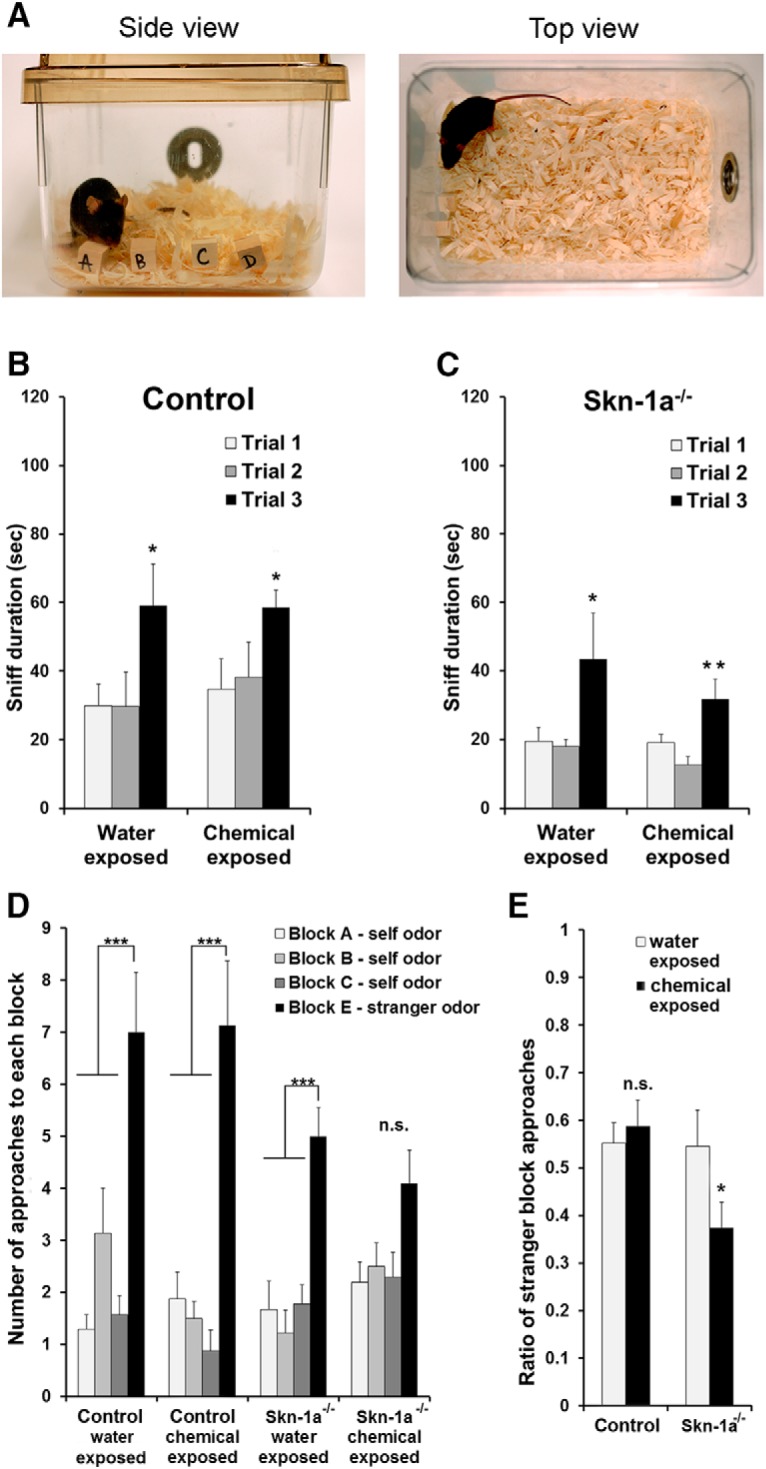
The number of approaches to a novel social odor is reduced in Skn-1a-/- mice after chemical exposure. A, Photographs of the experimental setting for the block test. Four scented blocks were placed into the cage. Left panel: side view, a mouse was sniffing block A. Right panel: top view. B, Sniff duration for each trial in water- and chemical-exposed groups of control mice. There were three trials total with each lasting 120 s. All blocks in trials 1 and 2 were scented with the mouse’s own odors. In trial 3, the block D was replaced with a block scented with a stranger odor (block E). Control mice of both water- and chemical-exposed groups sniffed significantly longer in trial 3 (*, p < 0.05, trial 3 vs. trial 2, t test, n = 7–8). C, Sniff duration for each trial in water- and chemical-exposed groups of Skn-1a-/- mice. Skn-1a-/- mice in both conditions displayed significantly longer sniff duration in trial 3 (*, p < 0.05, **, p < 0.01, trial 3 vs. trial 2, t test, n = 9–10). D, Number of approaches to each block during trial 3 in water- or chemical-exposed groups of control and Skn-1a-/- mice. In control mice, both water- and chemical-exposed groups approached the block scented with a stranger odor significantly more than the three blocks scented with the mouse’s own odors (***, p < 0.0001, one-way ANOVA, n = 7 and 8). Similarly, water-exposed Skn-1a-/- mice also approached the stranger odor block significantly more (***, p < 0.0001, one-way ANOVA, n = 9). However, chemical-exposed Skn-1a-/- mice failed to show significantly more approaches to the stranger scented block compared with other blocks scented with their own odors, although the number trends higher [one-way ANOVA (p = 0.0341), Bonferroni corrections vs. the stranger scent block (Ps > 0.05)]. E, Comparison of preference index. The index was calculated using the number of approaches to the stranger scented block versus the number of approaches to all blocks. Although the preference index is very similar between the water- and chemical-exposed groups of control mice, the ratio of chemical-exposed Skn-1a-/- mice was significantly lower than the ratio of water-exposed Skn-1a-/- mice (*, p < 0.05, t test, n = 9 and 10).